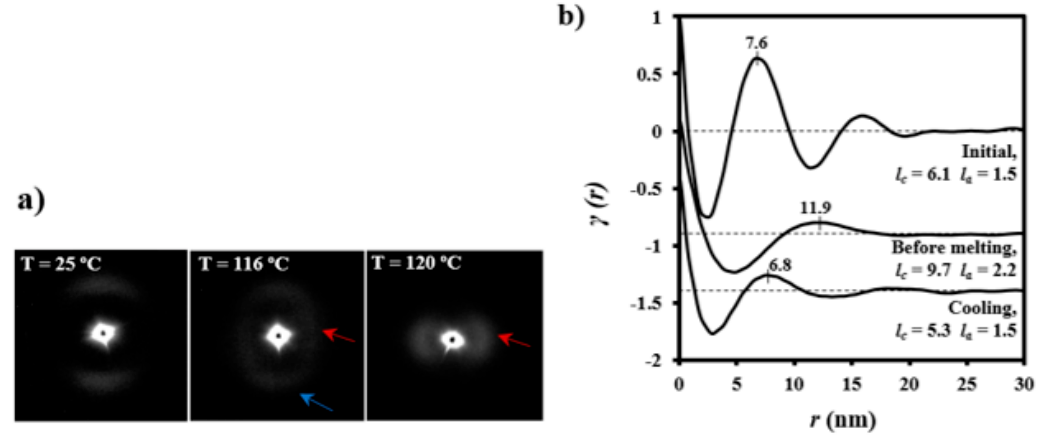
Figure 11. ( a ) SAXS patterns of a PDO suture taken at representative temperatures during a heating run at 10 °C/min. Blue and red arrows indicate meridional and equatorial reflections, respectively; ( b ) Correlation function of diffraction patterns corresponding to: the initial suture, a suture heated (10 °C/min) just before melting and a melt crystallized (cooling rate of 10 °C/min) suture at room temperature.